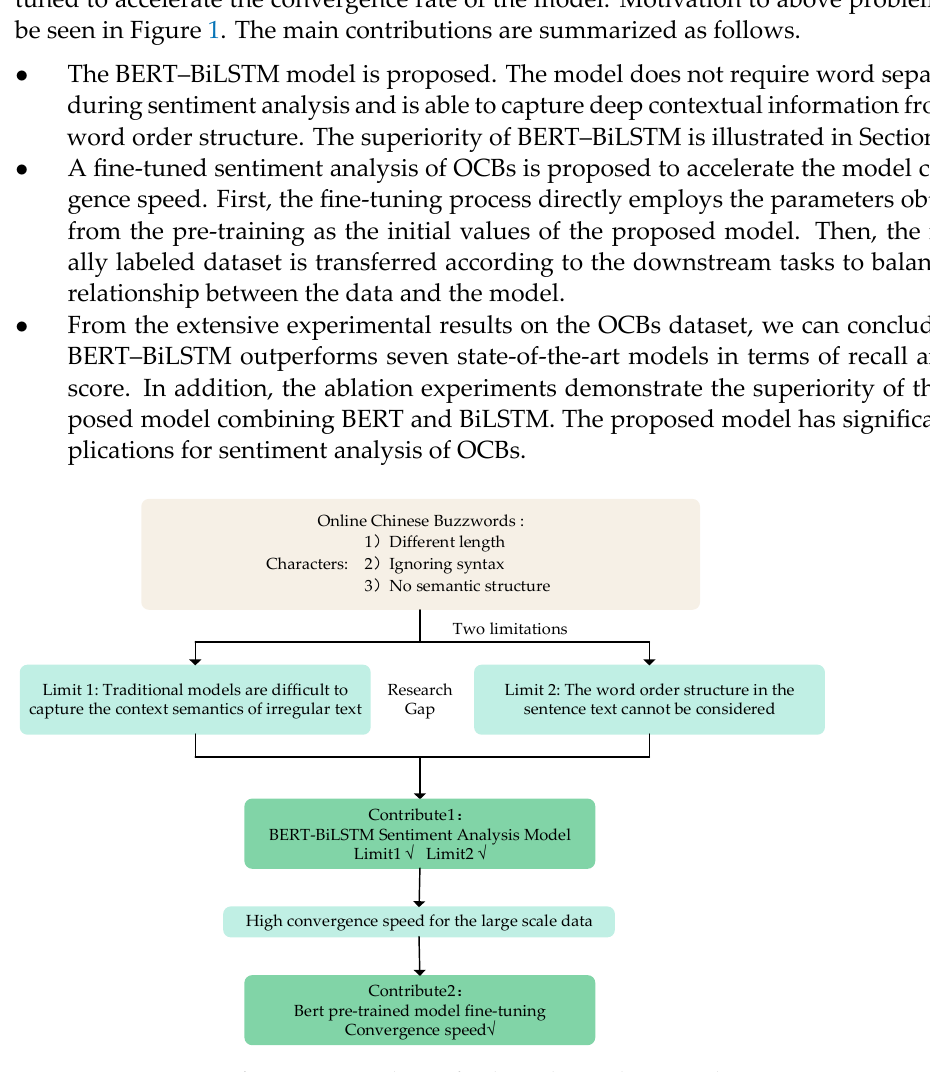
Figure 1. Motivation of sentiment analysis of online Chinese buzzwords.